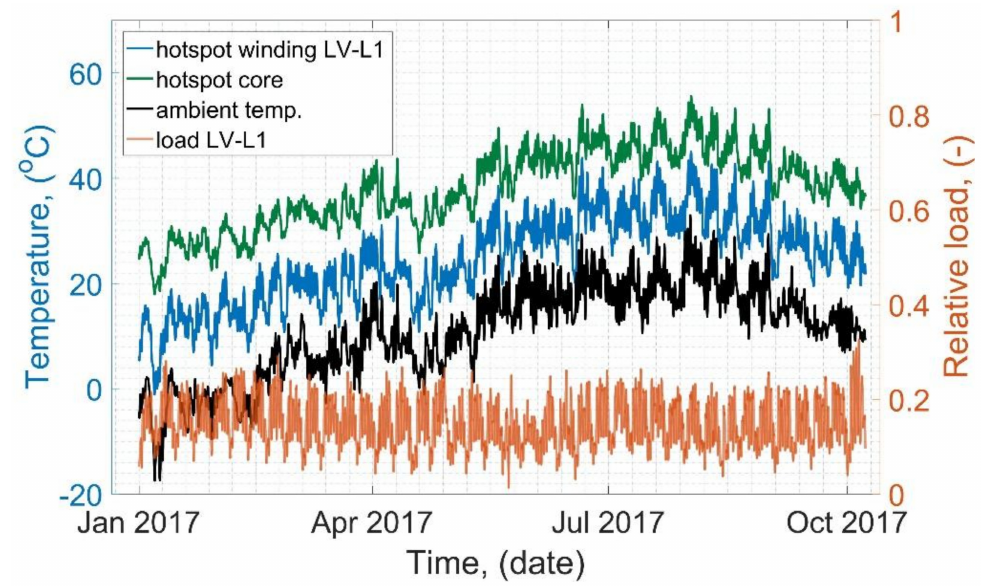
Figure 3. Exemplary temperature and load variability of the